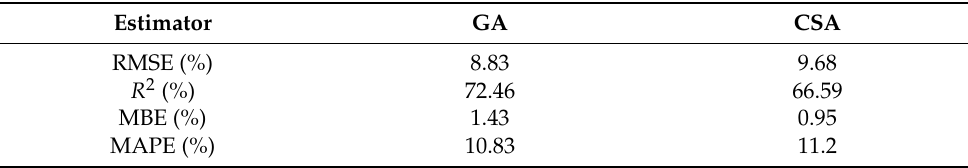
Table 6. Cross-validation with 10 runs for the GA and CSA.